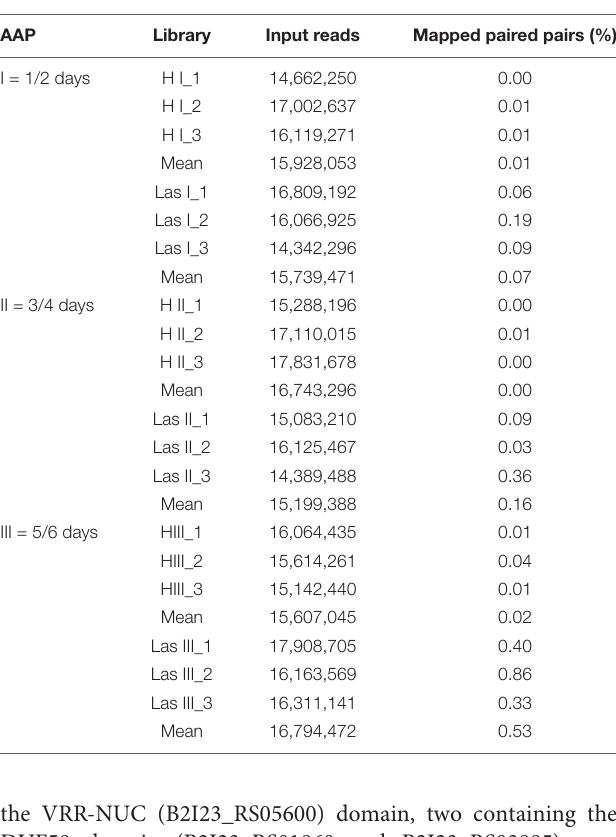
TABLE 3 | Transcript read mapping against “ Candidatus Liberibacter asiaticus” (Las) JXGC strain (NZ_CP019958.1) from sequenced libraries prepared with enriched mRNA from Diaphorina citri gut samples, reared either in healthy (H) or in Las infected-citrus shoots (Las), for increasing (I, II, and III) acquisition access periods (AAP).